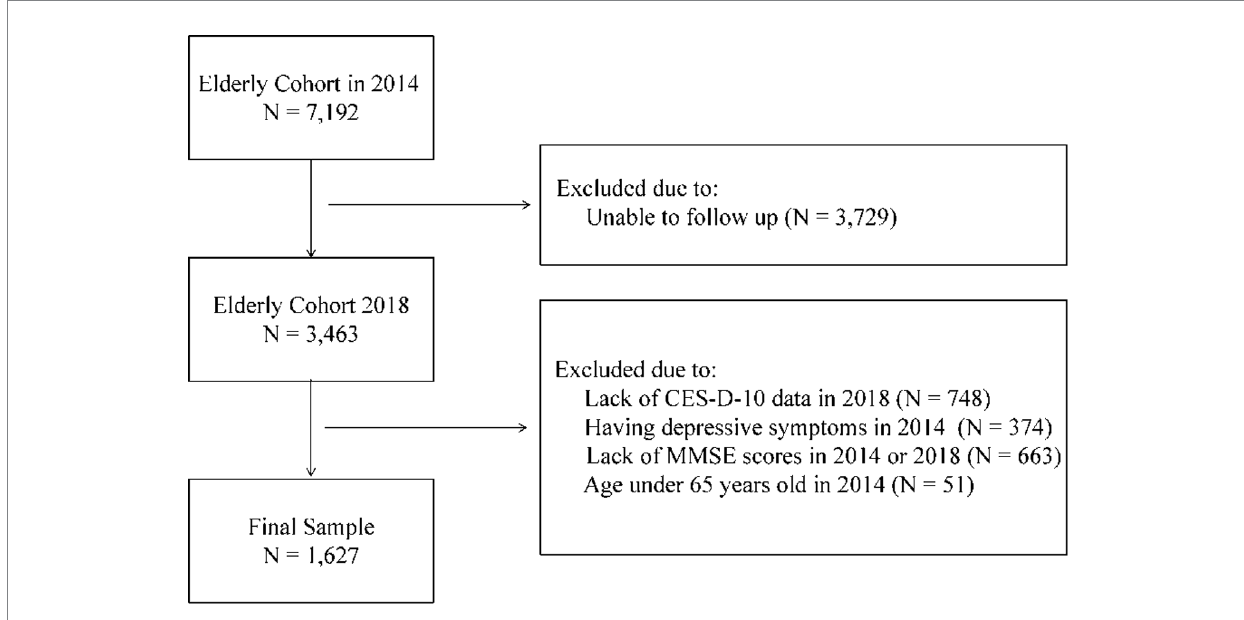
FIGURE 1 Flow chart of study sample